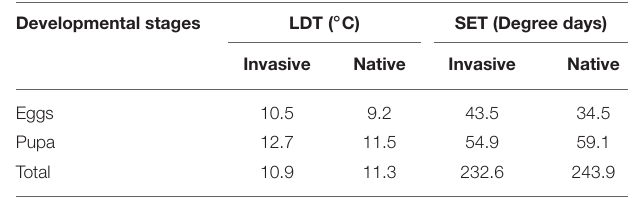
TABLE 7 | Lower development threshold (LDT) and sum of effective temperatures (SET) at seven constant temperatures in species invasive to the